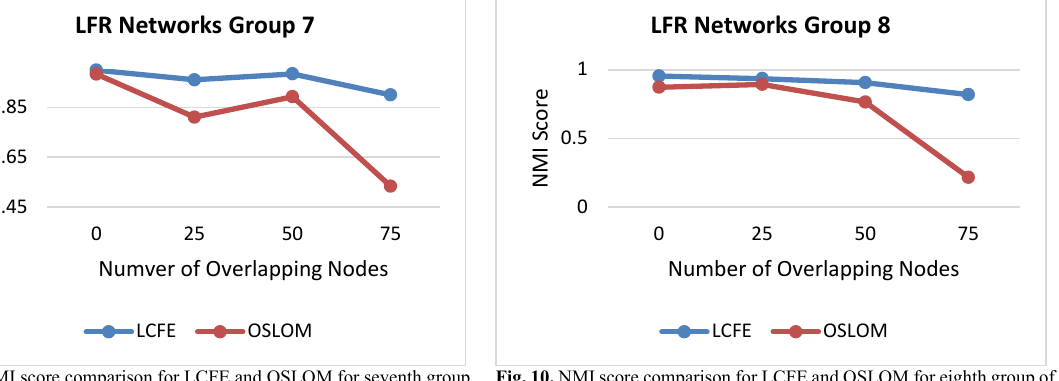
Fig. 10. NMI score comparison for LCFE and OSLOM for eighth group of LFR Networks with number of overlapping nodes ranging from 0 to 75